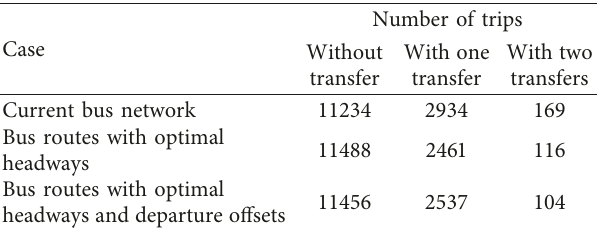
Table 6: Number of trips for the current bus network and modelling